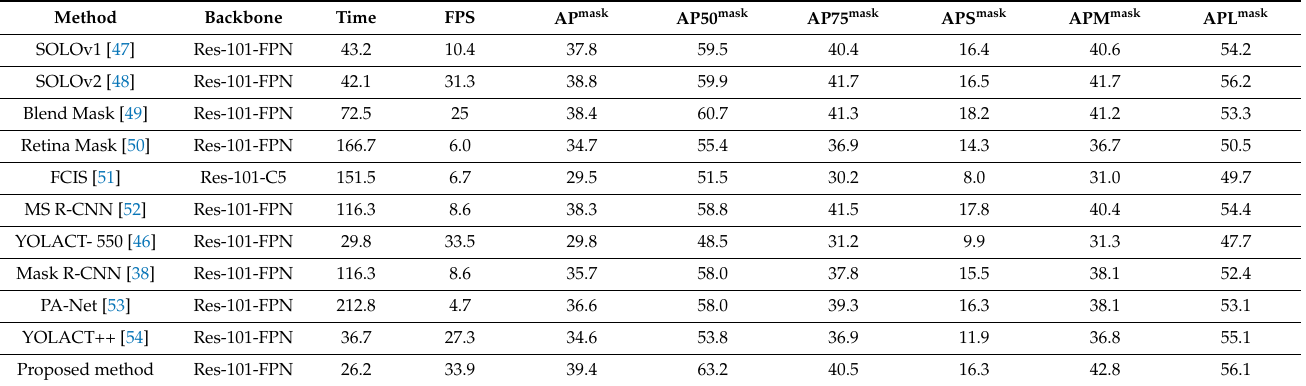
Table 3. Quantitative comparison of the proposed method with existing methods in terms of accuracy and